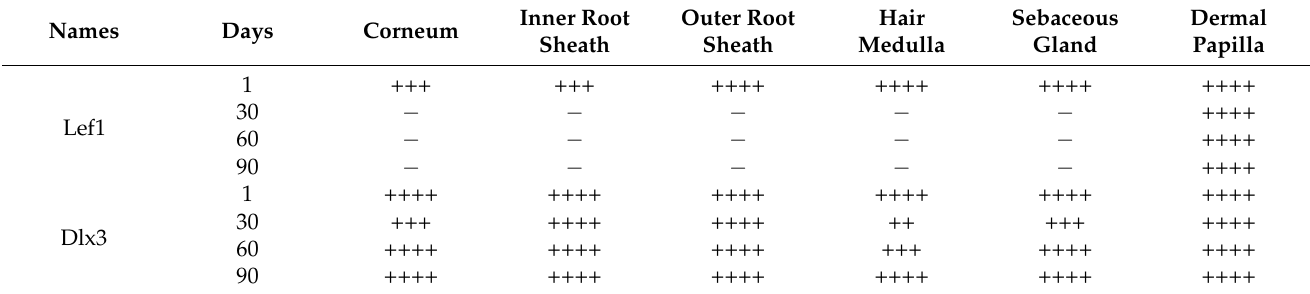
Table 2. Distribution density of Lef1 and Dlx3 in various parts of skin tissues at various